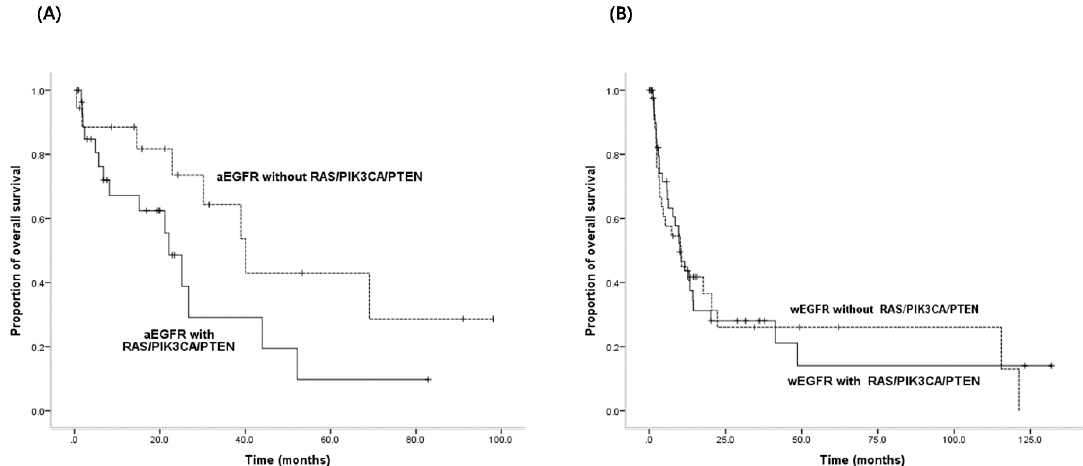
Figure 1. Overall survival in patients with or without RAS/PIK3CA/PTEN mutations according to comprehensive EGFR activating mutational status. ( A ) OS in patients with activating EGFR mutations according to RAS/PIK3CA/PTEN mutations ( p = 0.080): patients with RAS/PIK3CA/PTEN mutations displayed shorter OS than the patients without mutations. ( B ) OS in patients with wild-type EGFR according to RAS/PIK3CA/PTEN mutations ( p = 0.932): OS was not different between the two groups. For the univariate analysis, younger age (≤65 years), female sex, never smoker and activating